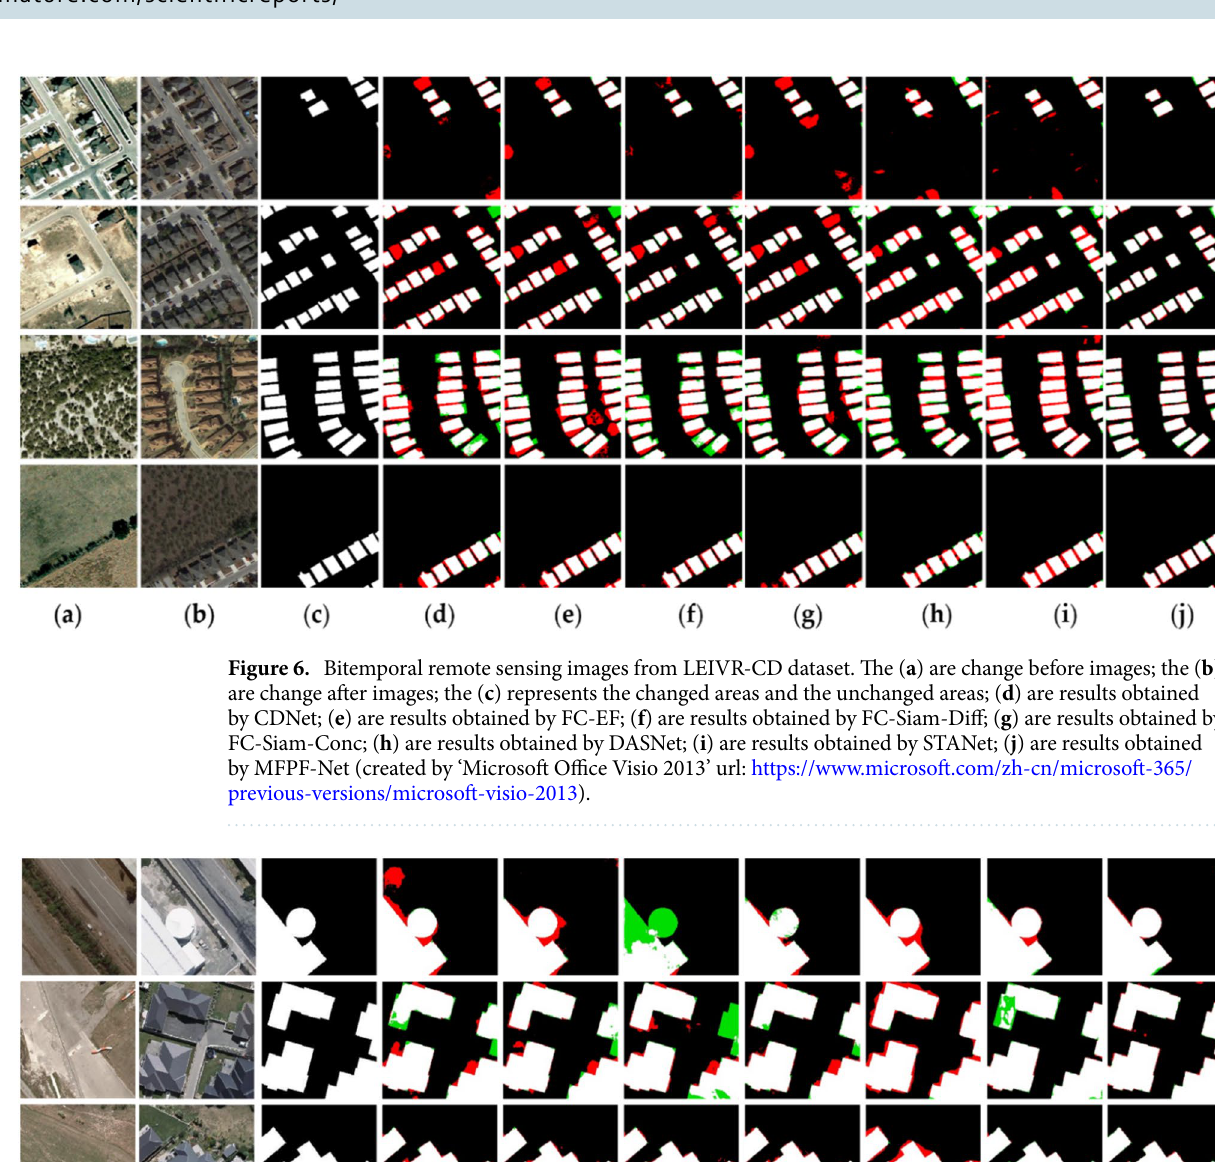
8.3% and 3.3% higher than STANet and DASNet, respectively. Although the R of the MFPF-Net is similar to the